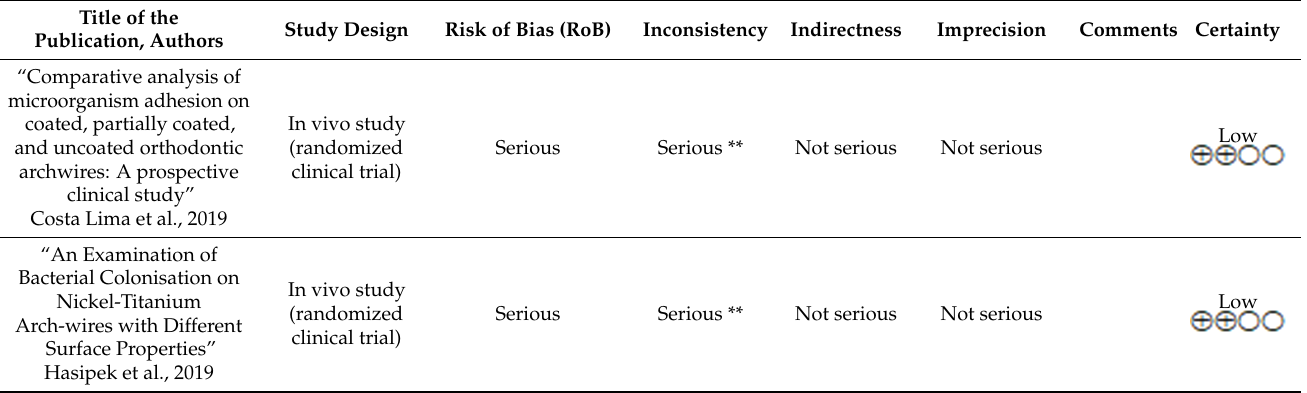
Table 4. The GRADE analysis for in vivo studies.